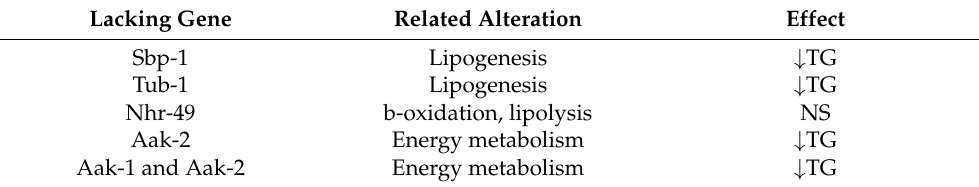
Table 4. Effects of isorhamnetin treatment in mutant nematodes lacking lipid metabolism related genes. Lacking Gene Related Alteration Effect Sbp-1 Lipogenesis ↓ TG Tub-1 Lipogenesis ↓ TG Nhr-49 b-oxidation, lipolysis NS Aak-2 Energy metabolism ↓ TG Aak-1 and Aak-2 Energy